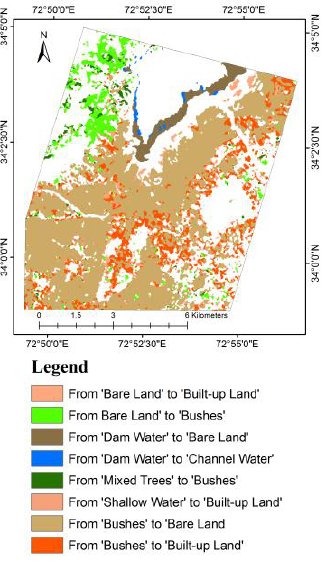
Figure 6. Change detection results of OLI SVM classified